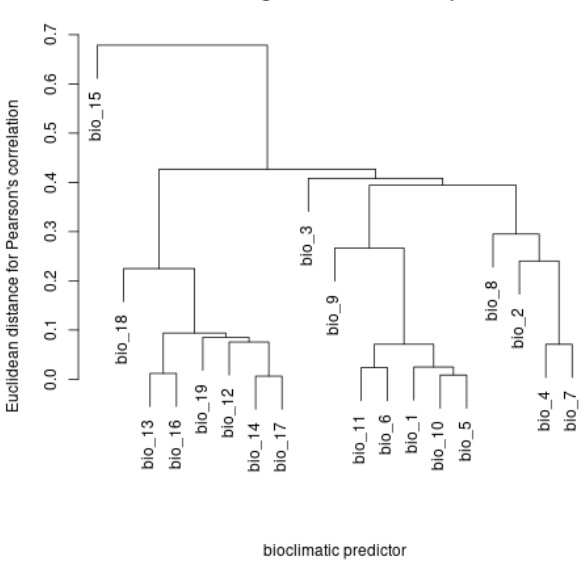
Figure A1. Dendrogram of the Hierarchical Clustering for the Pearson’s Correlation Coefficients among Rasters of Bioclimatic Variables.